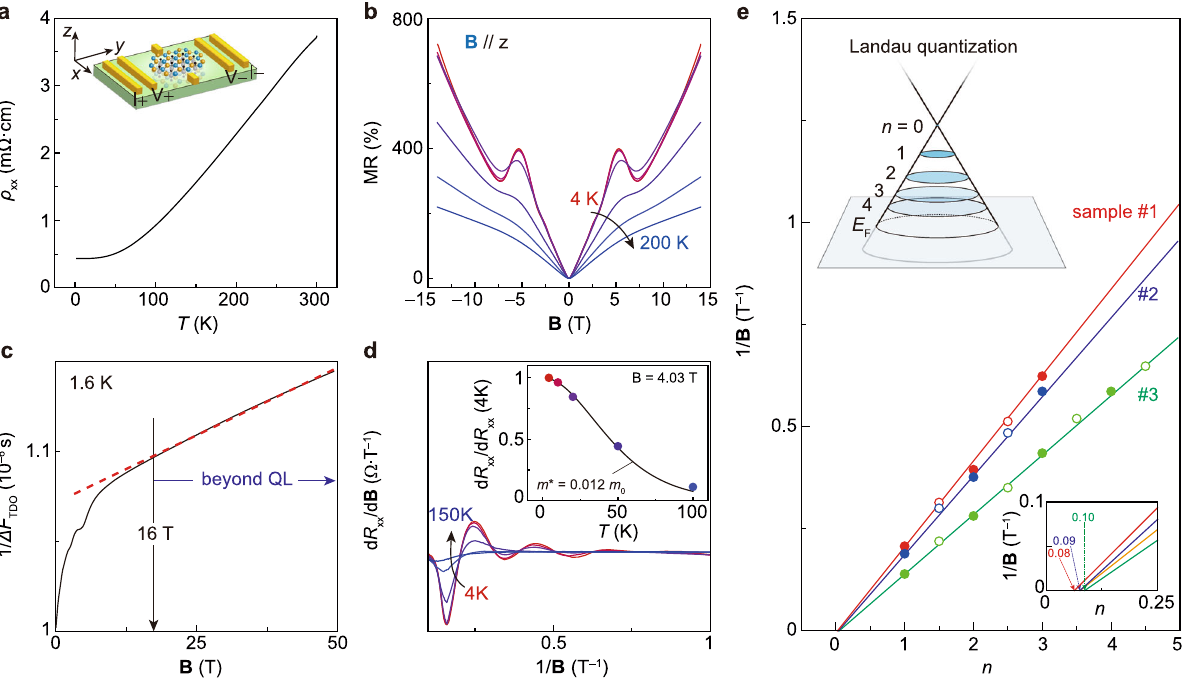
Fig. 2 Evidence of nontrivial Berry phase in 3D TDS KZnBi. a T -dependent ρ xx , which shows a metallic behavior of DFs. Illustration for transport measurements is shown in the inset. b MR data in the range of − 14 T ≤ B ≤ 14 T at 4 K ≤ T ≤ 200 K. c TDO data in the range of 0 T ≤ B ≤ 49 T at 1.6 K. The linear MR (red dashed line) shows quantum limit behavior. d SdH oscillations in d R xx /dB at 4 K ≤ T ≤ 200 K (colored lines in the main panel) and T -dependent oscillation amplitudes (colored circles in the inset) at B = 4.03 T. m * ≅ 0.012 m 0 is obtained from Lifshitz – Kosevich analysis (black line in the inset). e Landau fan diagram for three KZnBi samples (red, blue, and green for samples #1, #2 and #3, respectively), which has integer indices ( fi lled circles) and half-integer indices (open circles). Landau quantization with integer indices is described in the left top inset. The x -intercepts (right bottom inset) that are lying between 0 and ±1/8 imply a nontrivial Φ B .